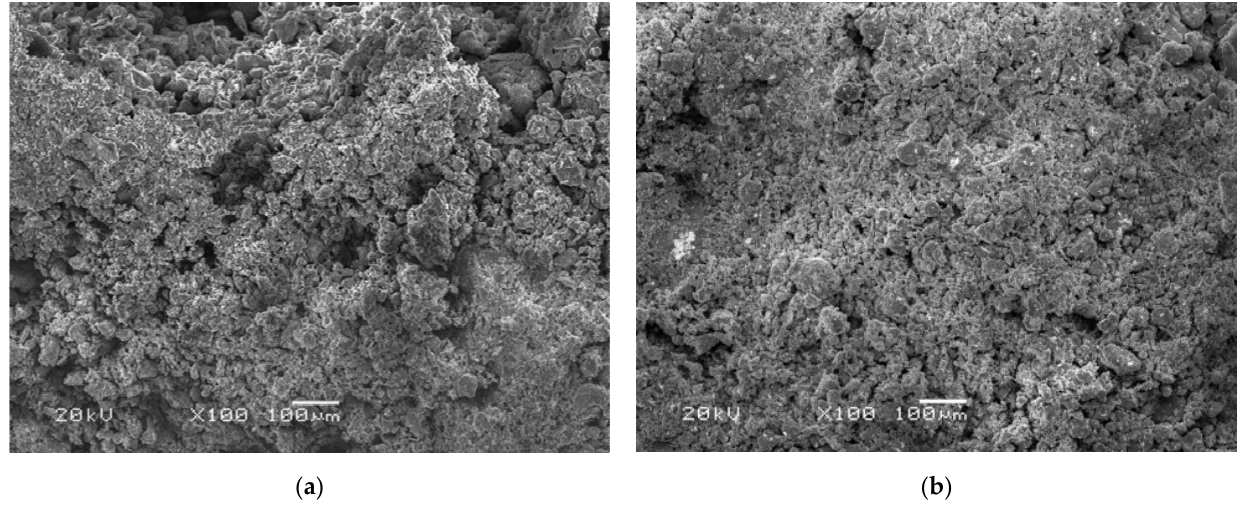
Figure 2. Scanning electron microscopy images: ( a ) untreated sample and ( b ) consolidated sample.